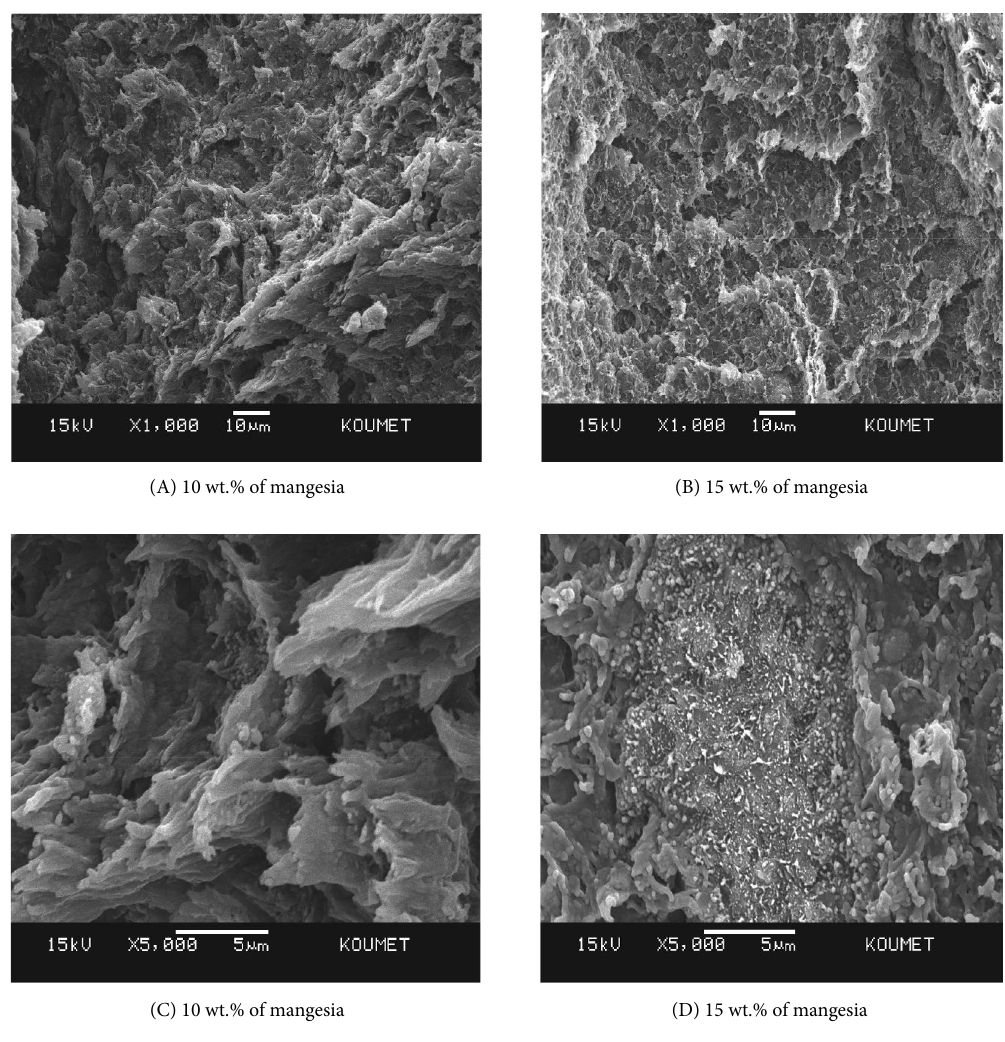
Figure 7: SEM micrographs of PS/Magnesia composites with respect to magnesia loading level (Magnification; × 1000, ×